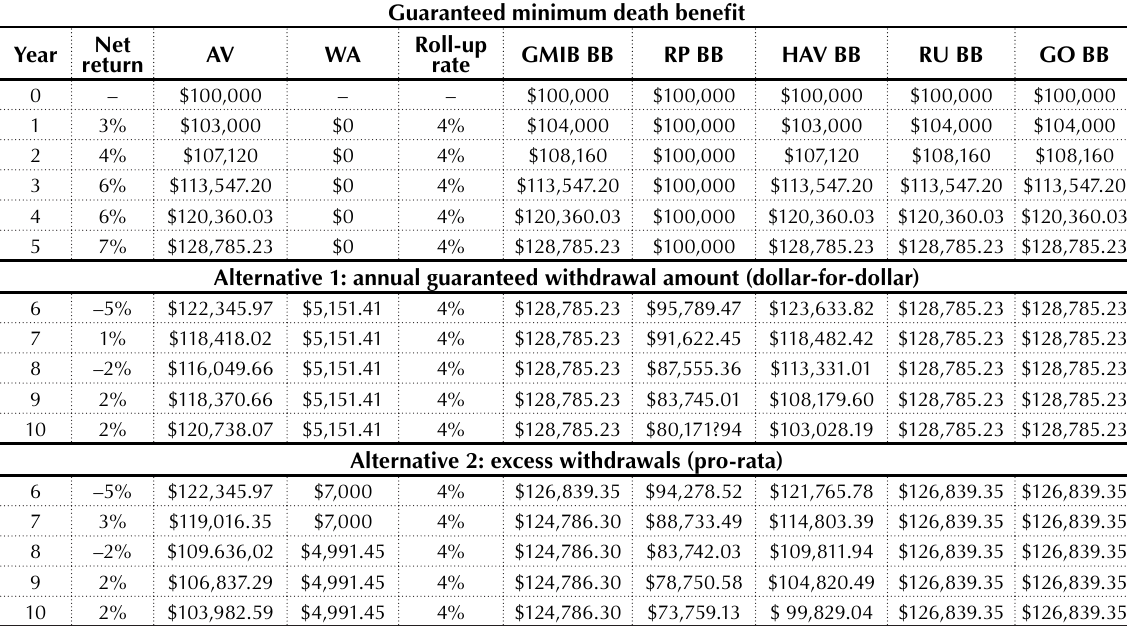
Table 3. GMIB and GMDB behavior given policyholder’s withdrawals when the account value is less than the GMIB benefit base at the time of the first withdrawal Guaranteed minimum death